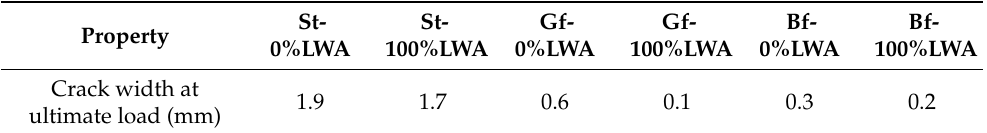
Figure 10. Sketches for cracking patterns at failure for all beams. Table 10. Ultimate crack width of all